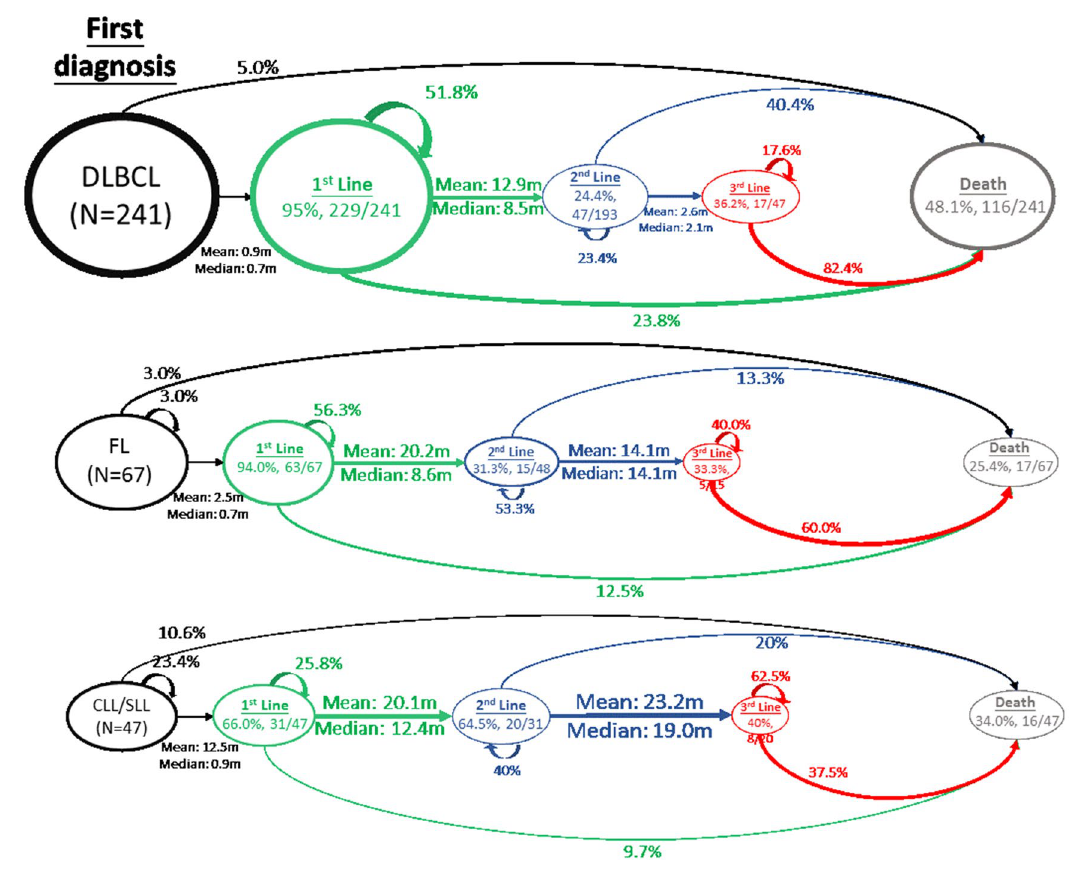
Figure 6. Disease progression models for DLBCL, FL and CLL. CLL/SLL, small lymphocytic lymphoma and chronic lymphocytic; DLBCL, diffuse large B-cell lymphoma; FL, follicular lymphoma. SAS 9.4 was used to calculate the probability of transition and duration of lines of treatments and Microsoft Visio was used to draw the